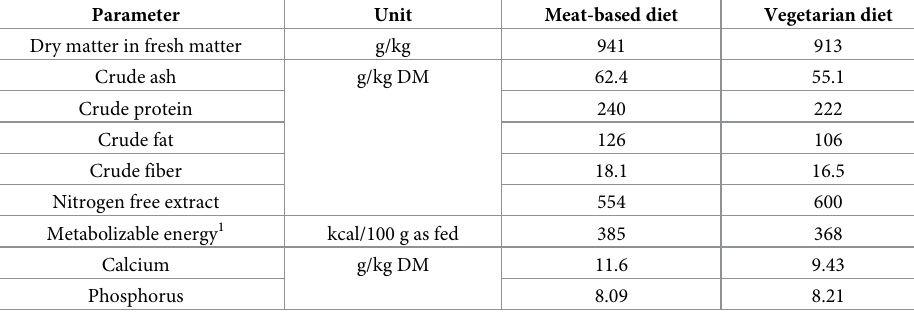
Table 2. Chemical composition of meat-based diet and vegetarian